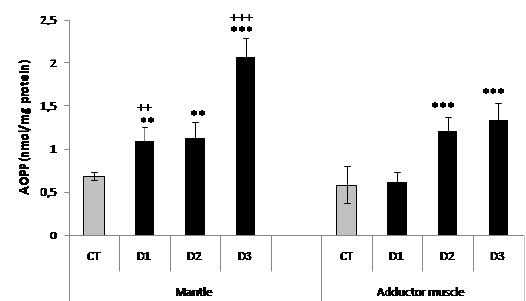
Figure 3. The AOPP levels in the control and treated M. stultorum mantle and adductor muscles with Pb Cl 2 graded doses (D1, D2, D3) during 5 days. Values are expressed as means ± SD, 6 replicate in each group and tissues (n = 3 clams). Pb Cl 2 graded doses: D1 (1mg / L Pb Cl 2 ); D2 (2.5mg / L Pb Cl 2 ); D3 (5mg / L Pb Cl 2 ). ** P < 0.01;*** P < 0.001: Pb Cl 2 groups VS controls for each tissue. ++ P < 0.01; +++ P < 0.001: mantle VS adductor muscles for